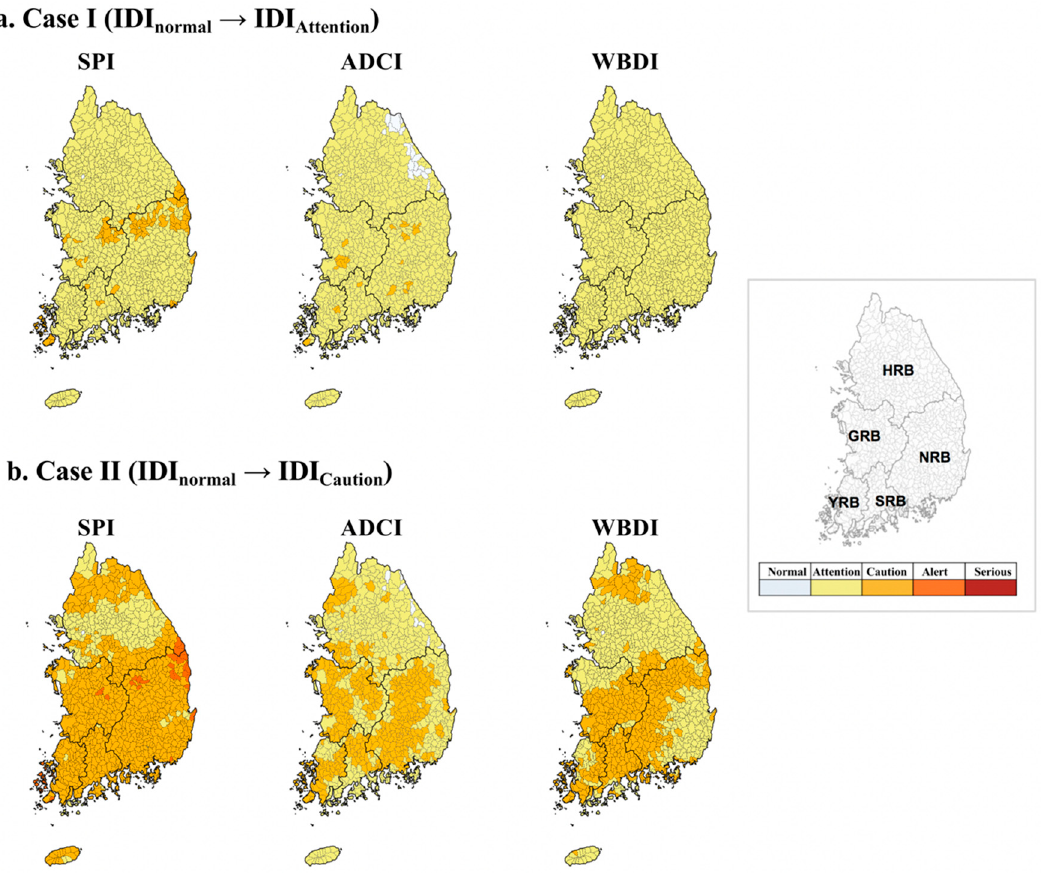
Figure 11. Drought condition changes in IBB simulation. ( a ) Case I (IDI normal → IDI Attention ) and ( b ) Case II (IDI normal → IDI Caution ). The simulation results for the five basin areas for up to three months are colored in the map.